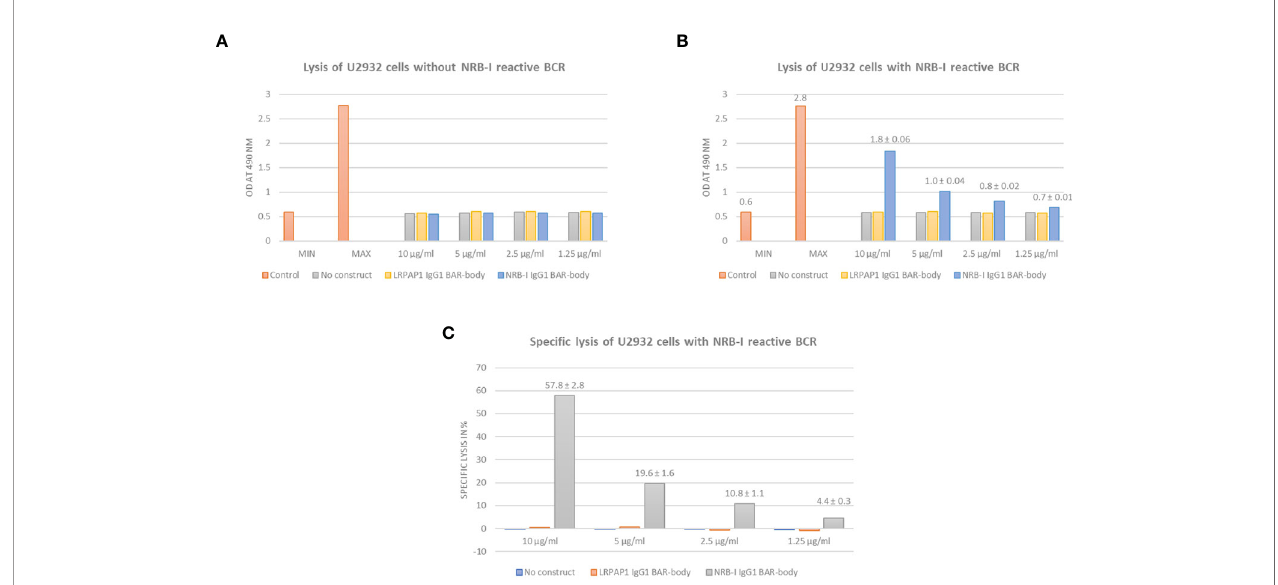
FIGURE 6 | IgG1-format neurabin-I BAR-body induced PBMC-mediated speci fi c cytotoxicity as measured by LDH release. IgG1-format BAR-bodies incorporating LRPAP1, an irrelevant BCR antigen of mantle cell lymphomas, were used as controls. All experiments were performed in triplicate. (A) IgG1-format neurabin-I BAR- body at different concentrations (1.25 – 10 µg/ml) incubated with U2932 DLBCL cells and PBMCs (E:T ratio of 10:1) results in no LDH release indicating no unspeci fi c IgG1-format BAR-body induced cytotoxicity. (B) IgG1-format neurabin-I BAR-body (concentrations 1.25 – 10 µg/ml) confers dose-dependent and PBMC-mediated cytotoxicity to U2932 DLBCL cells transfected with neurabin-I reactive BCRs at an effector to target ratio of 10:1. (C) IgG1-format neurabin-I BAR-bodies confer speci fi c lysis to U2932 cells transfected to express a neurabin-I reactive BCR (PBMC-mediated ADCC). LDH release is mediated in a dose-dependent manner, starting from 4% at 1.25 µg/ml going up to 58% at 10